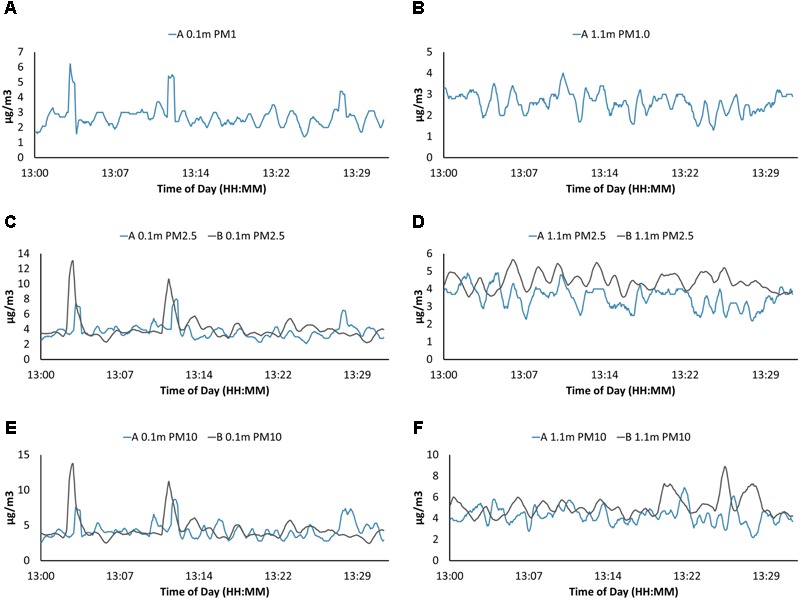
Particulate matter (PM) data from both PM sensors for USV missions on Claytor Lake, Dublin, VA, United States on October 3, 2017. Two models of optical particle counters PMS7003 (A) and SDS021 (B) were used. Only the PMS7003 (A) sensor was able to resolve PM1 at 0.1 m above the water surface (A) and PM1 at 1.1 m (B). Both models reported PM2.5 at 0.1 m (C), PM2.5 at 1.1 m (D), PM10 at 0.1 m (E), and PM10 at 1.1 m (F). Graphs are in general accordance both in shape and averages with some minor variations.